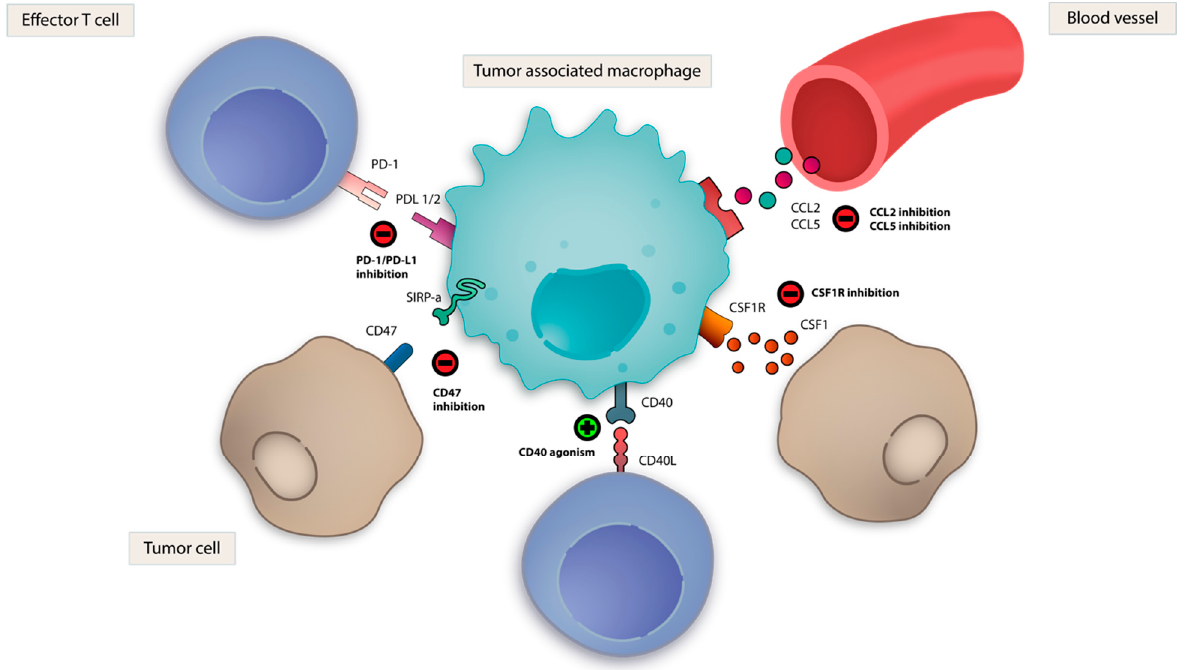
Figure 3. Strategies targeting TAMs. Multiple therapeutic strategies exist to target tumor-associated macrophages (TAMs) in cancer immunotherapy. CSF-1R inhibition and CD40 agonism promote TAM polarization to proinflammatory M1 phenotype. CD47-SIRP α blockade restores TAM-mediated phagocytosis. PD-1 blockade reverses TAM-mediated immunosuppression. CCL5 and CCL2 blockade attenuate TAM recruitment.